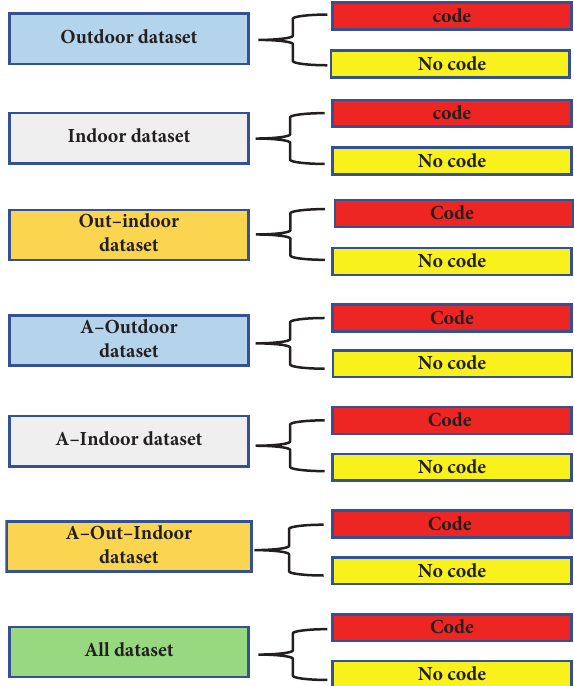
Figure 6: Model training structure.